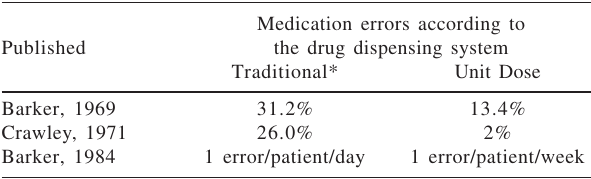
Table 1 - Medication errors in different drug-dispensing